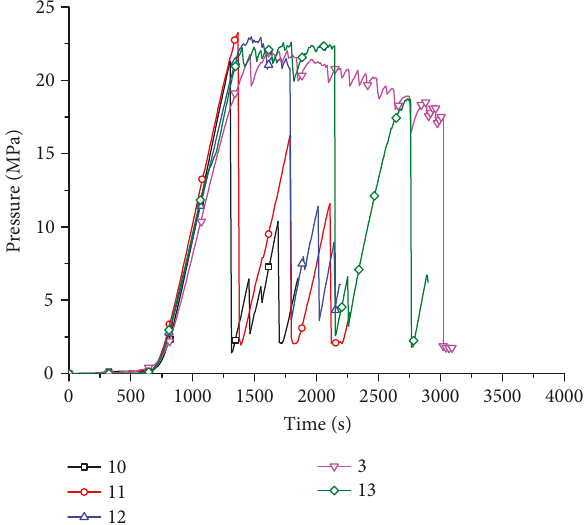
Figure 12: Pressure curves in the core fracturing process.